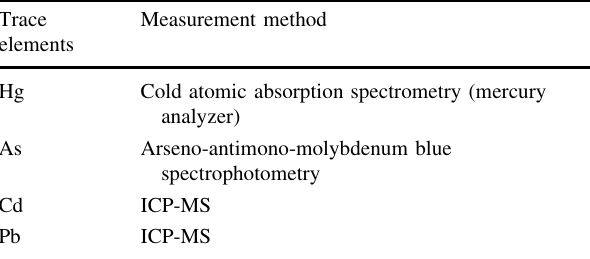
Table 3 Measurement for heavy metal elements in raw MZH coal and chars Trace